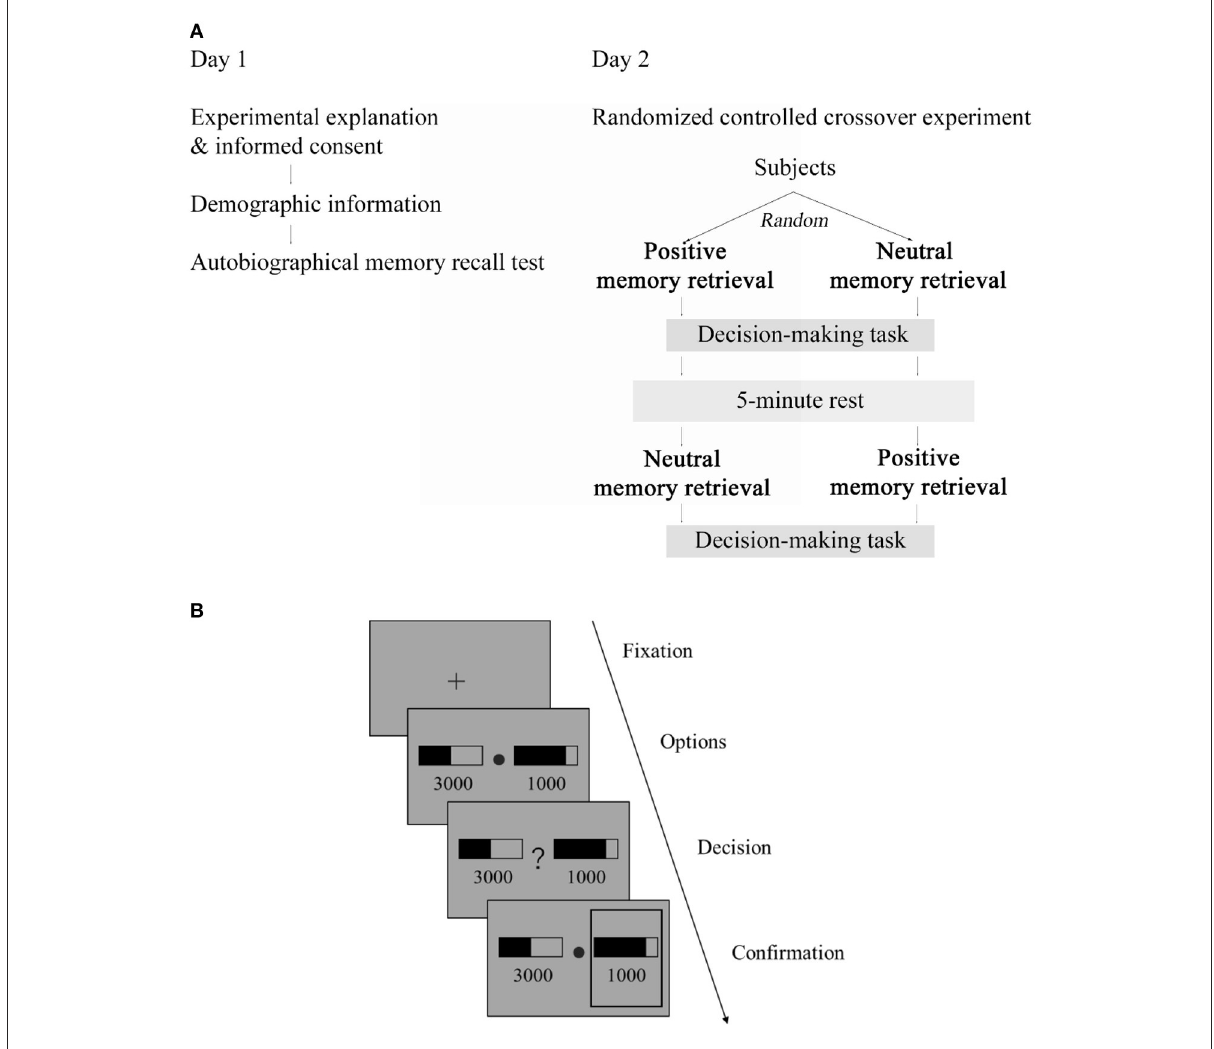
FIGURE1 Schematic illustration of the procedure and decision-making task. (A) Procedure, the study was conducted on two separate days: on day 1, subjects performed an autobiographical memory recall test; on day 2, they were assigned to receive memory retrieval intervention in a randmozed controlled crossover experiment. (B) Illustration of the decision-making task. After a fixation phase, two gambling options, each consisting of a reward magnitude (in JPY) and the probability of receiving that magnitude of reward (indicated by a black bar), were shown. A question mark then occurred in the center and subjects were asked to choose one option that maximized their reward. The chosen option was highlighted by a gray